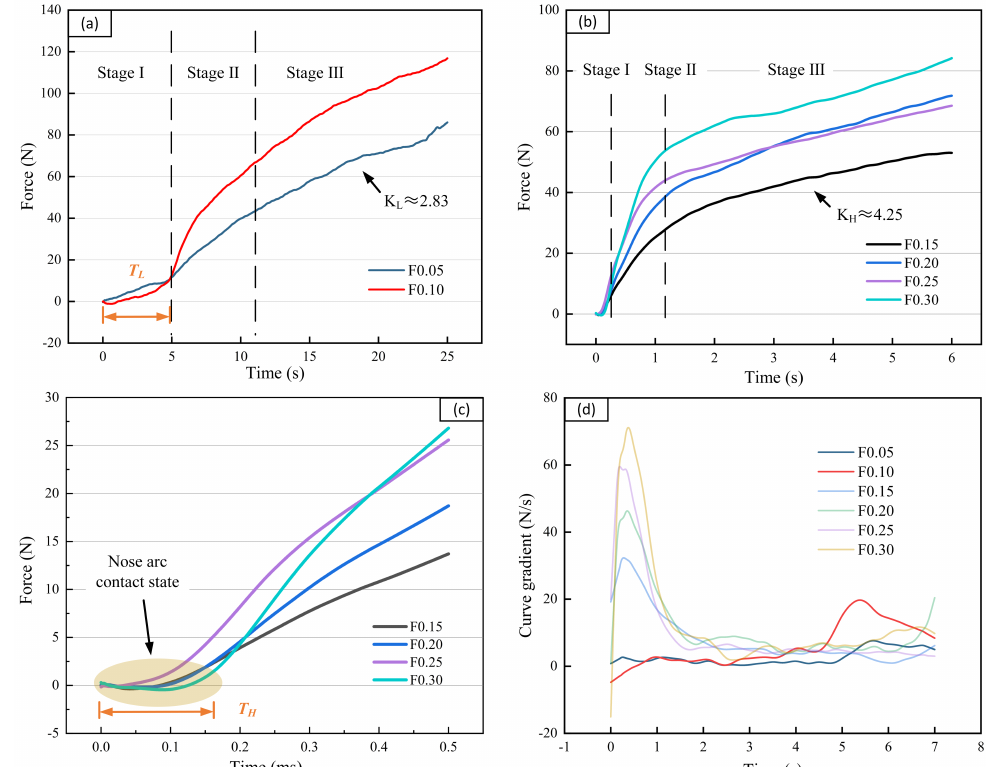
Figure 2. Comparison of cutting force curves at different feed rates: ( a ) cutting force at low feed; ( b ) cutting force at high feed; ( c ) enlarged curve of Stage I at high − feed rates; and ( d ) rate of curve at different feed